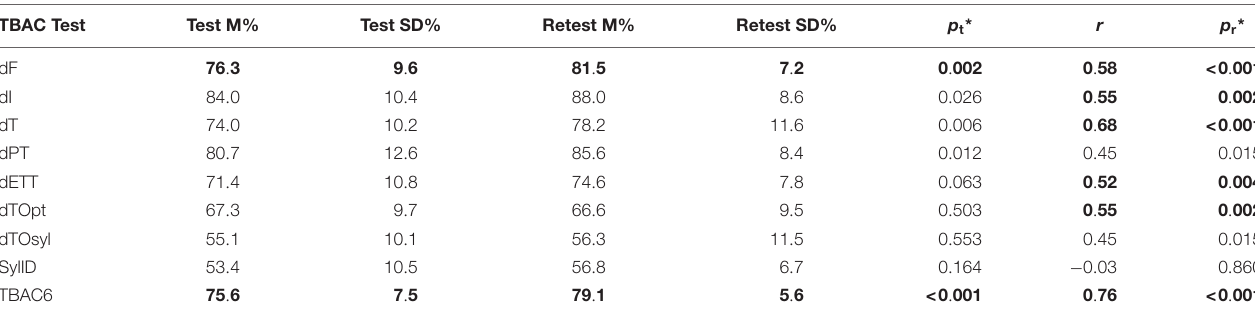
in Table 1 : dF, dI, dT, and dTOpt. The test-retest correlation for this TBAC4 average score was r = 0.71 ( p <